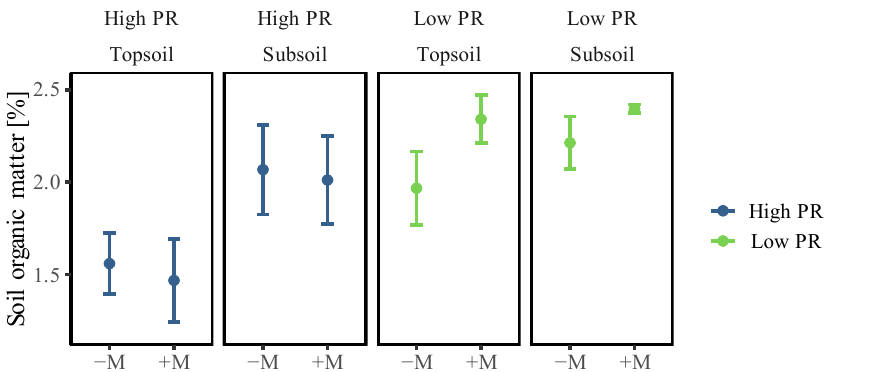
Figure 5. Organic matter content (OM in %) as a function of position and depth. Average ± standard deviation values. In each zone, there were no statistically significant differences ( p > 0.05) between treatments.